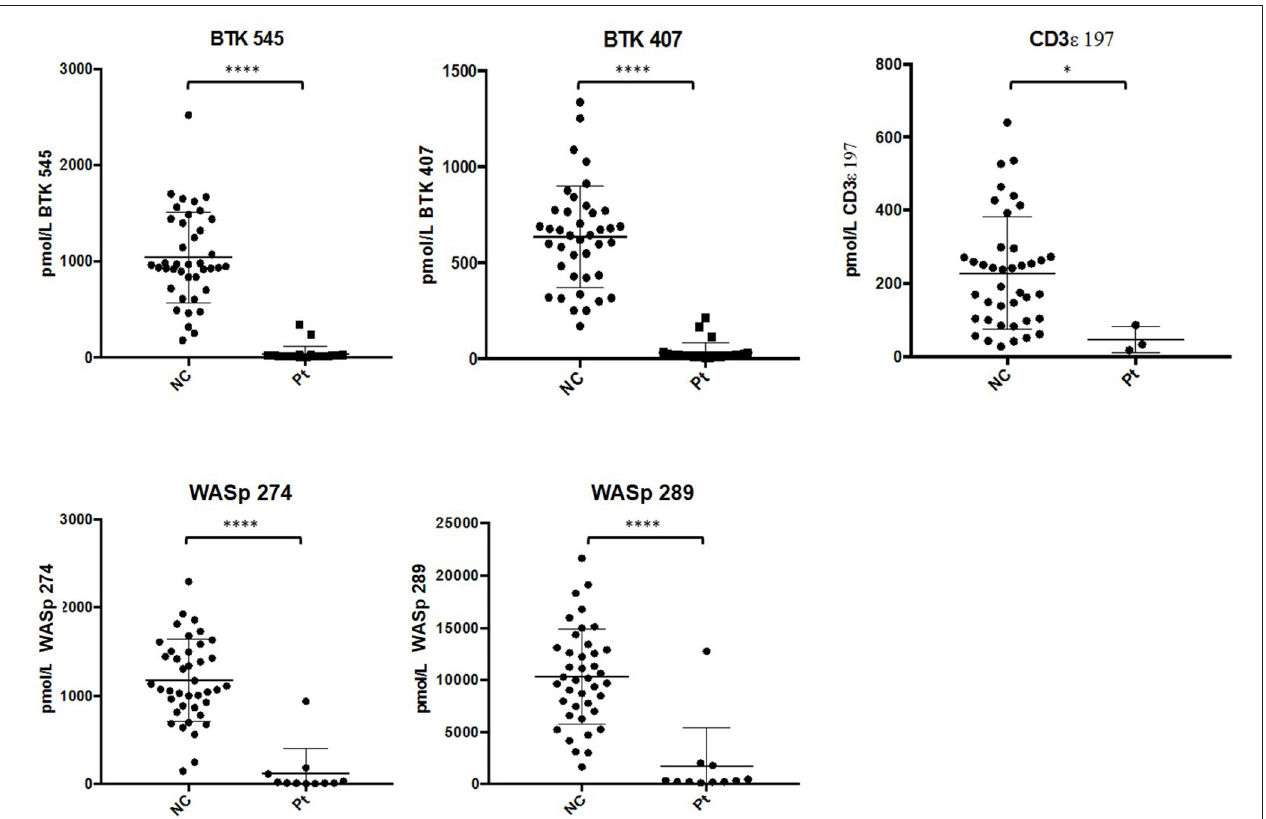
FIGURE 5 | Differences in signature peptide levels between patients (WAS: n = 11, XLA: n = 26, SCID: n = 3) and normal controls ( n = 40). Error bars indicate mean ± SD. WAS patient sample with high levels of WASp peptides was identified to be collected after bone marrow transplantation. **** p < 0.0001, * p < 0.05.